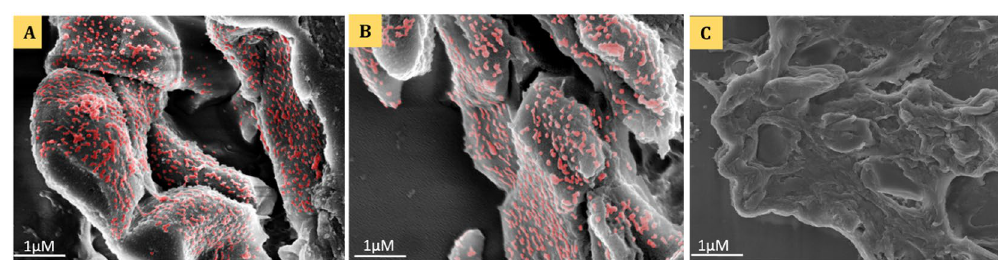
Figure 5. Scanning electron micrograph showing virus binding. Scanning electron micrograph showing binding of ( A ) avian H5N2 virus (A/H5N2/chicken/Pennsylvania/7659/1985) and ( B ) human H1N1 virus (A/H1N1/Virginia/2009) to little brown bat (LBB) trachea. ( C ) Mock controls were performed omitting virus incubation. Extensive binding of avian H5N2 and human H1N1 viruses to LBB trachea was observed. Virus or mock treated sections were fixed in ethanol and were coated with gold before imaging by a field emission SEM (FE-SEM, Merlin Zeiss) under 5 eV. Virus particles were pseudo-colored using Adobe Photoshop